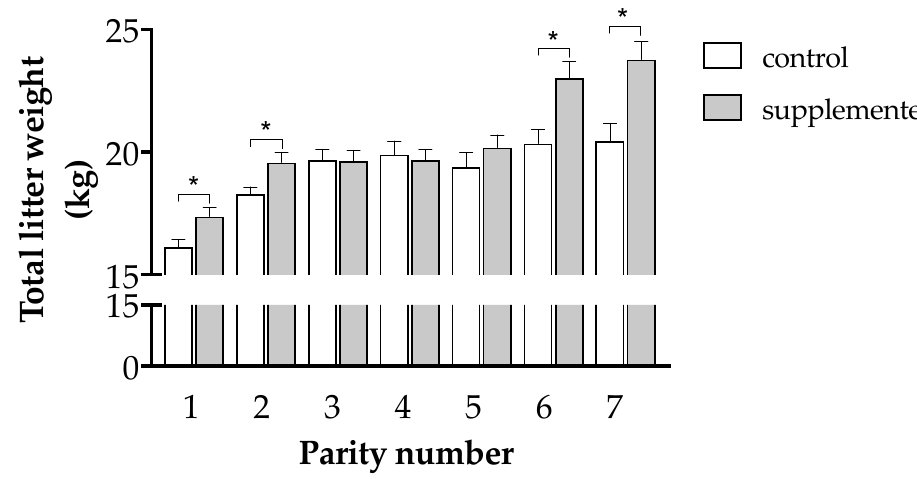
Figure 4. Mean (± S.E.M.) litter weight according to parity in sows treated or not with herbal antioxidants. Asterisks denote significant differences between groups ( p < 0.05). The treated group showed a trend for a decrease in the total number of piglets with a birth weight under 1 kg ( p = 0.07), with its incidence being around 9% lower than in the controls due to a significantly higher number of piglets with a birth weight above 1 kg (around 0.84 additional piglet per litter; p < 0.001; Figure 5).